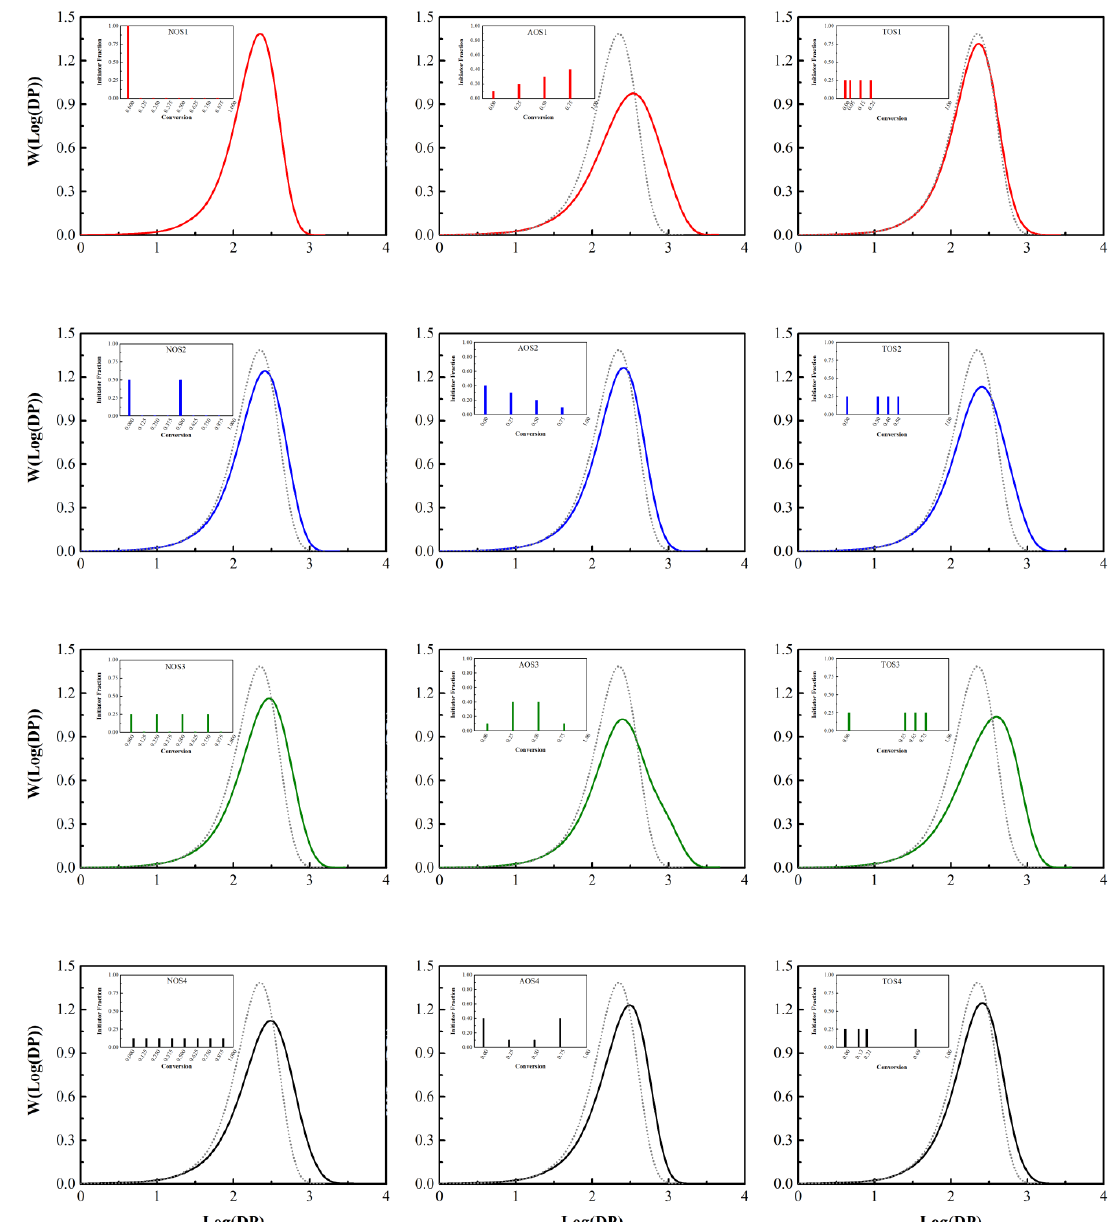
Figure 4. Final molecular weight distributions in semi-batch free radical polymerization of styrene = 6.06 mol L –1 , [ S ] = 2.54 mol L –1 , [ I ] = 0.075 mol L –1 , and a temperature of 138 ◦ C (Case 2) with [ M ] 0 0 0 for the three di ff erent initiator feeding policies (insets). Solvent mole fraction about 30%; S refers to solvent. Left column: NOS; middle column: AOS; right column: TOS. For comparison, the top left (NOS-1) result is presented in every other plot as a dotted